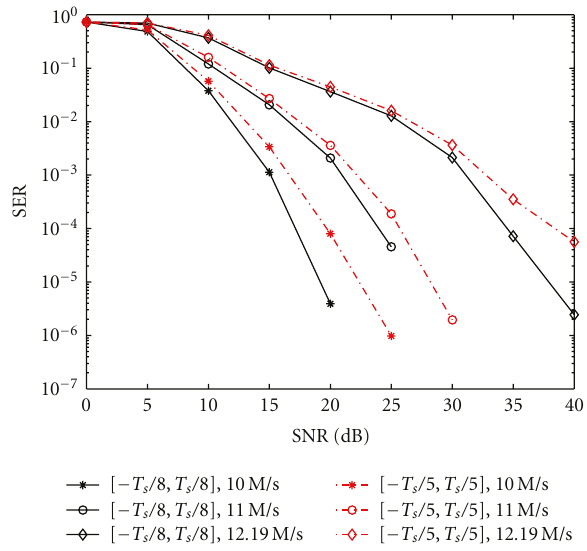
Figure 10: SER performance comparison for di ff erent amounts of random delays, with CFOs randomly chosen within the range [0,0 . 001 /T s